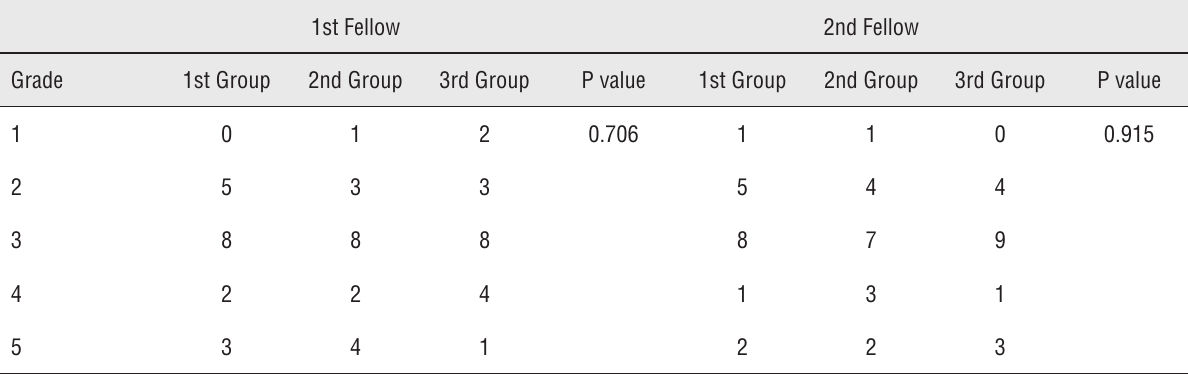
Table 2 - Number of ureter units according to grade of reflux for each